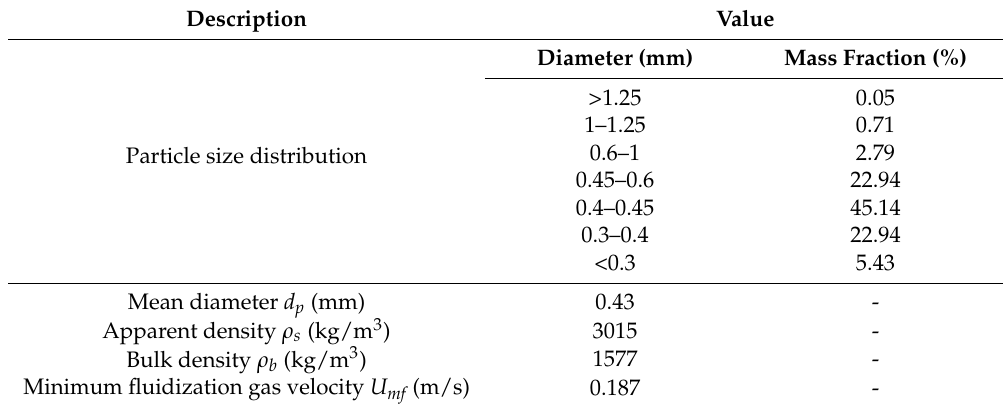
Table 1. Main physical properties of the oxygen